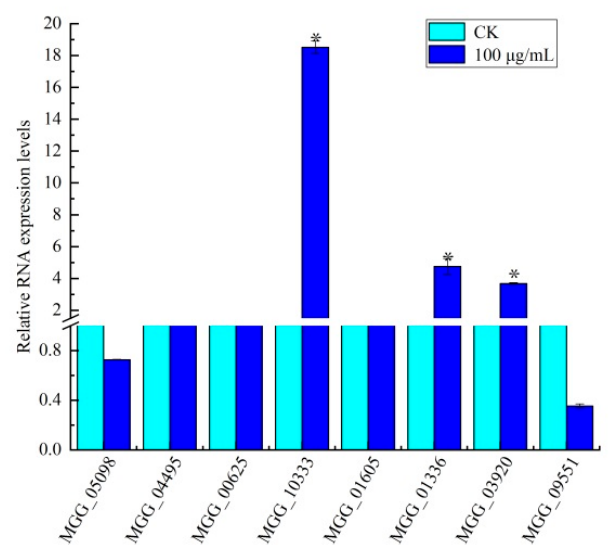
Figure 6. RT-qPCR analysis of key genes in the amino and nucleotide sugar pathways in response to citral treatment of M. oryzae after 24 h of treatment with citral (100 µ g/mL). Significance is denoted by *.